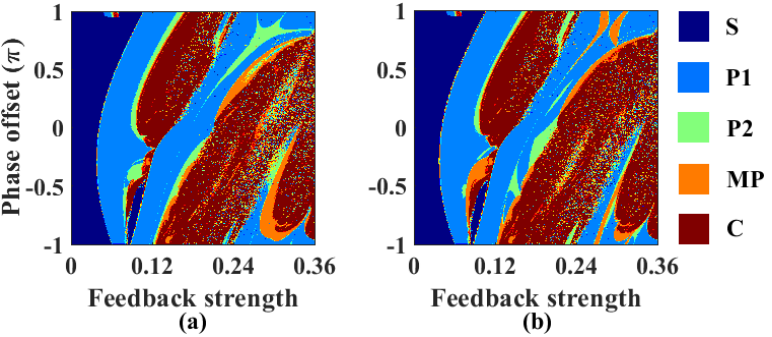
Figure 6. Mapping of the dynamical states for GS lasing ( a ) and ES lasing ( b ) of a TSQDL in the parameter space of feedback strength and phase offset. S: stable, P1: period-one, P2: period-two, MP: multi-period, and C: chaos.